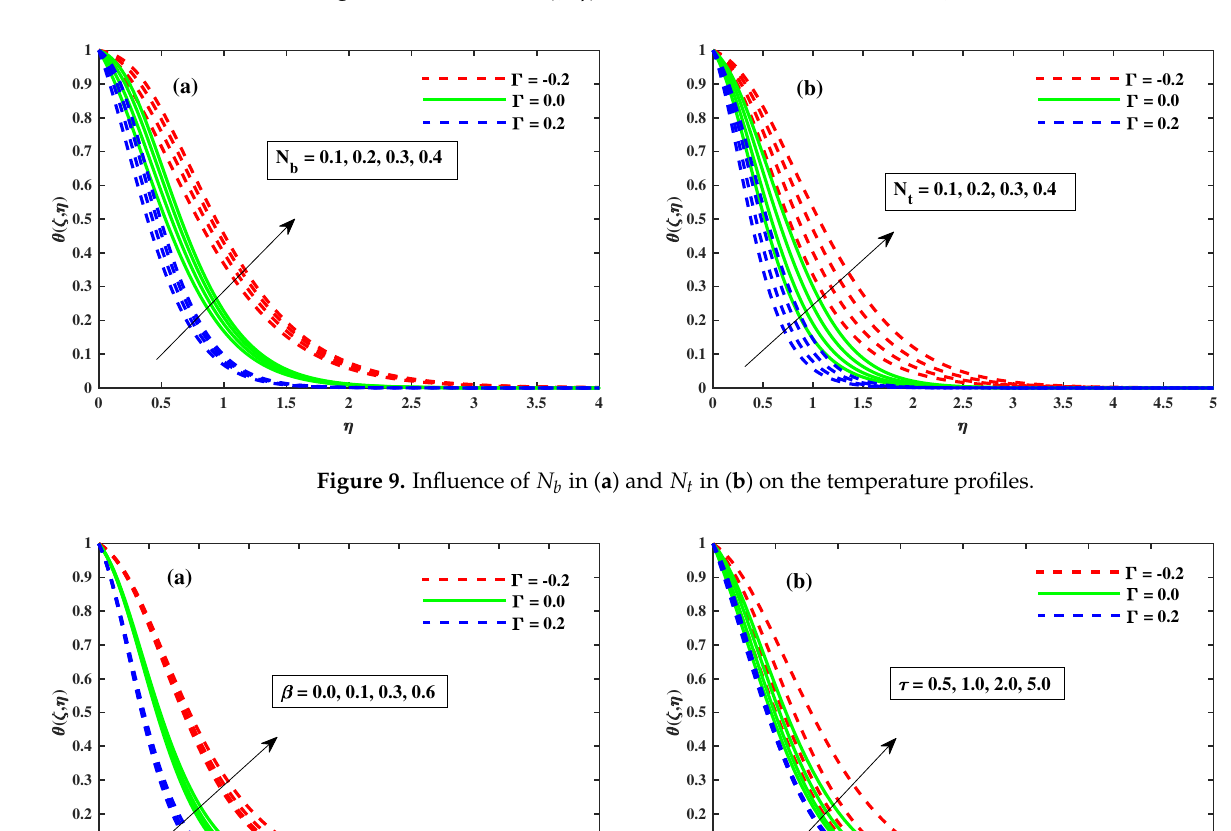
Figure 8. Variation of θ ( ζ , η ) for M in ( a ) and for λ in ( b ) when ζ = 1.